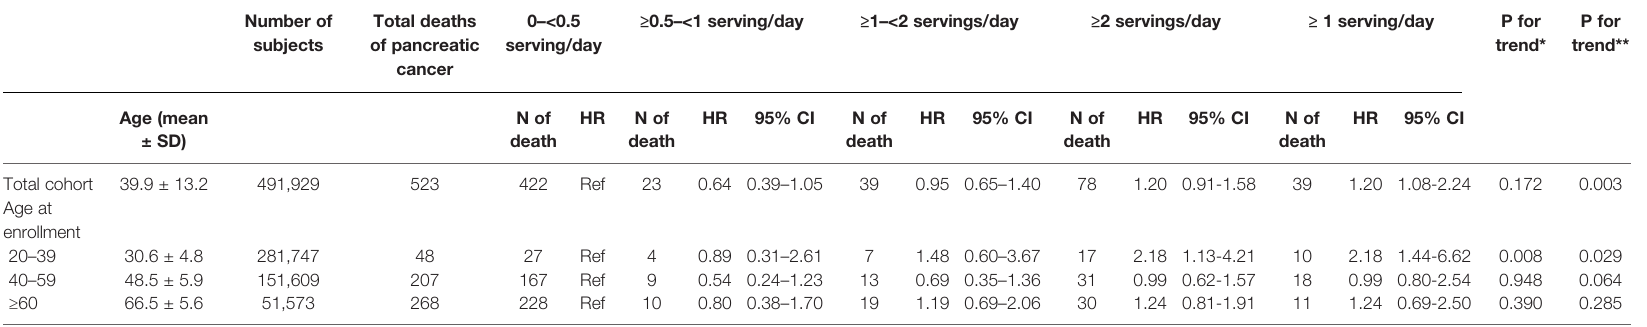
TABLE 3 | The mortality risks of pancreatic cancer by levels of consumed sugar-sweetened beverages.